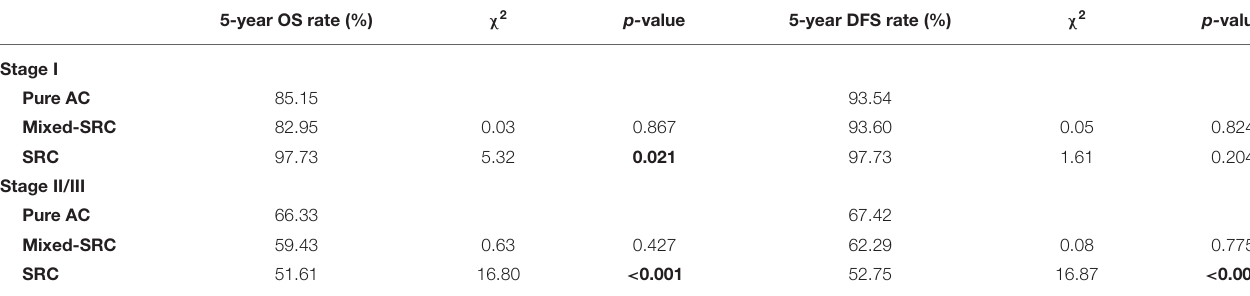
TABLE 4 | Comparison of the 5-year OS/DFS rate according to different subgroups.